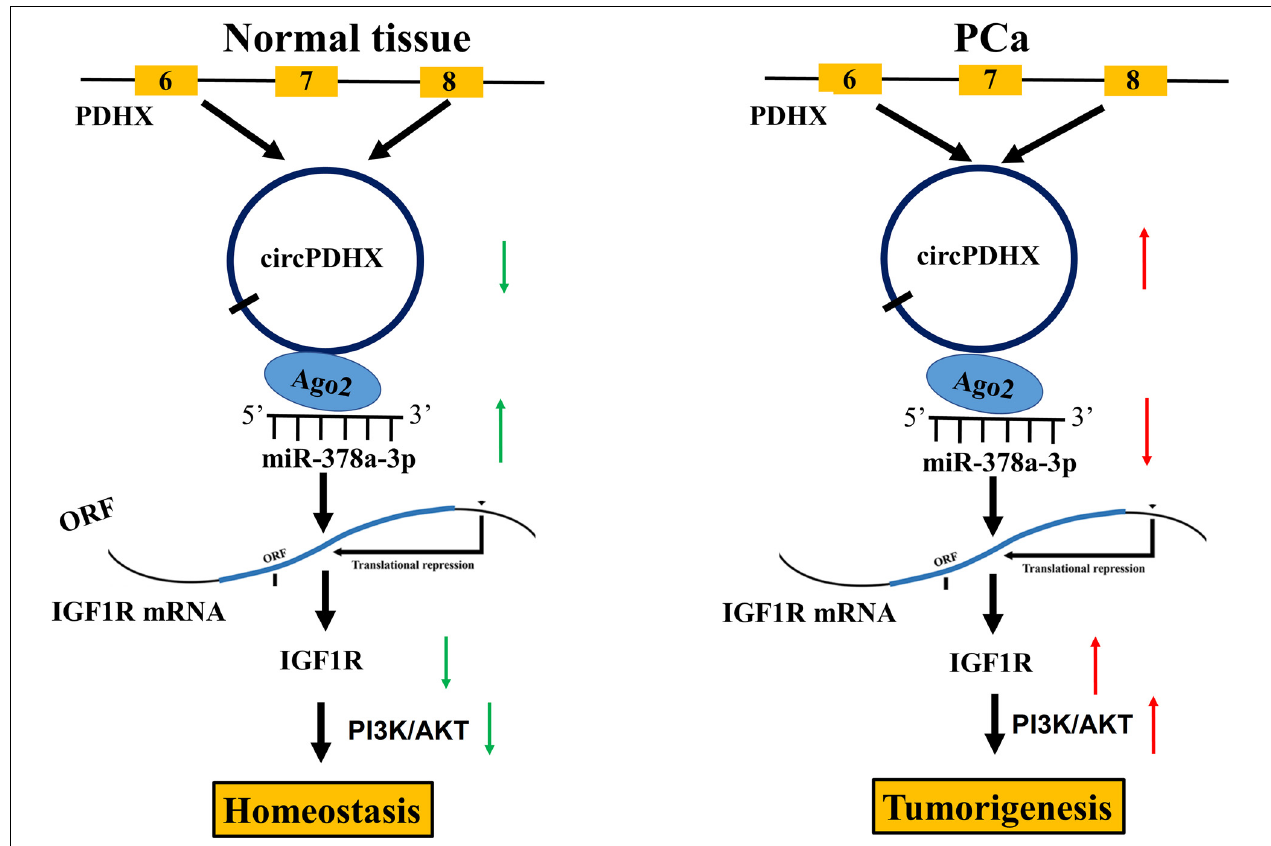
FIGURE 8 | Schematic representation of the proposed mechanisms of circPDHX in prostate cancer (PCa). circPDHX acted as a sponge of miR-378a-3p to upregulate IGF1R expression, contributing to the tumorigenesis of PCa.